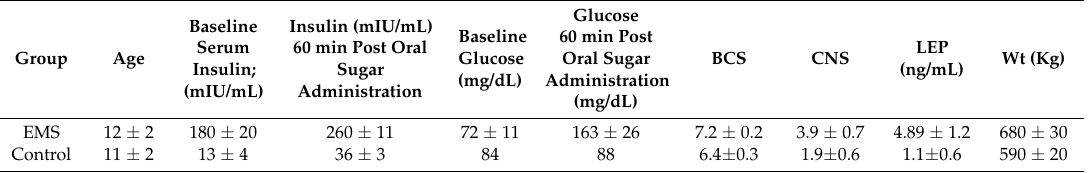
Table 1. Characterization of equine metabolic syndrome (EMS) horses and healthy (control) horses.